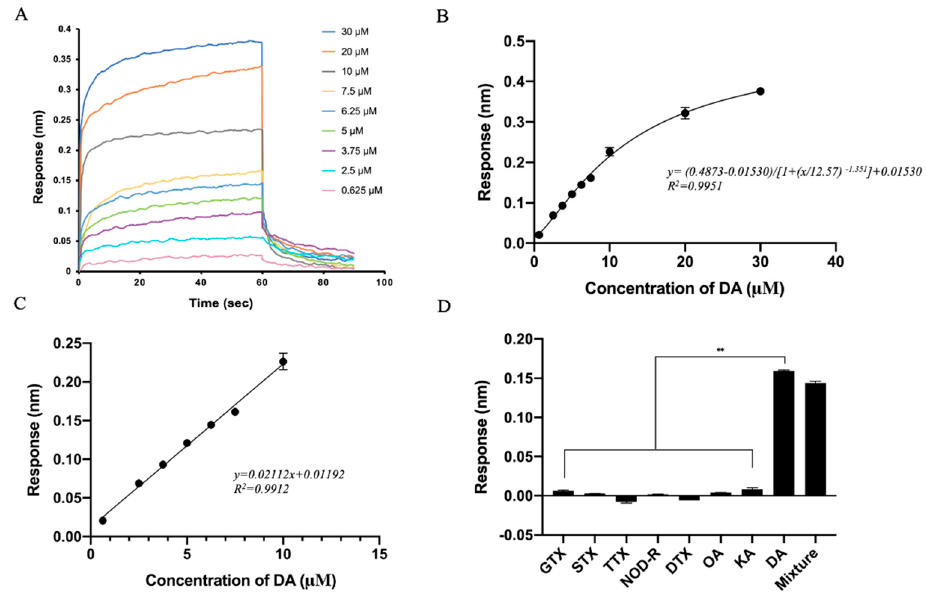
Figure 7. Evaluation of the BLI-based aptasensor. ( A ) Response value curve of the aptasensor at different concentrations of DA (0.625 to 30 µ M). ( B ) Calibration curve of response values at different concentrations of DA (0.625 to 30 µ M). ( C ) The linear range of the calibration curve of DA in the concentration of 0.625 to 10 µ M. ( D ) The specificity of BLI-based aptasensor to various toxins (DA, GTX, STX, TTX, NOD-R, DTX, OA, KA each at 6.25 µ M) and the mixture of the abovementioned toxins (the final concentration of each marine biotoxin was 6.25 µ M). A random sequence was used as a control. The error bars represent standard deviations. ** p < 0.01 vs. DA (control). Table 3. Detection of DA in real samples ( n = Table 2. The precision of aptasensors in different concentrations of DA ( n = 3).